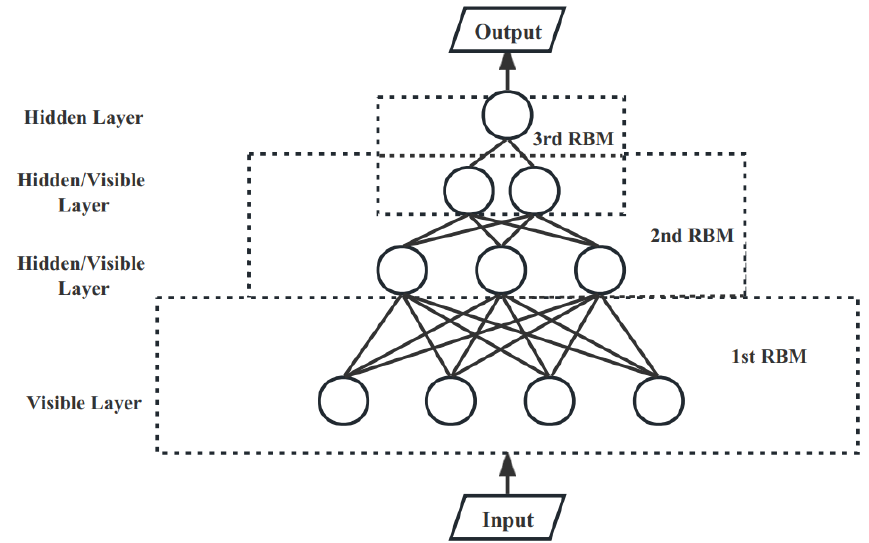
Figure 10. Multi-layer RBM.